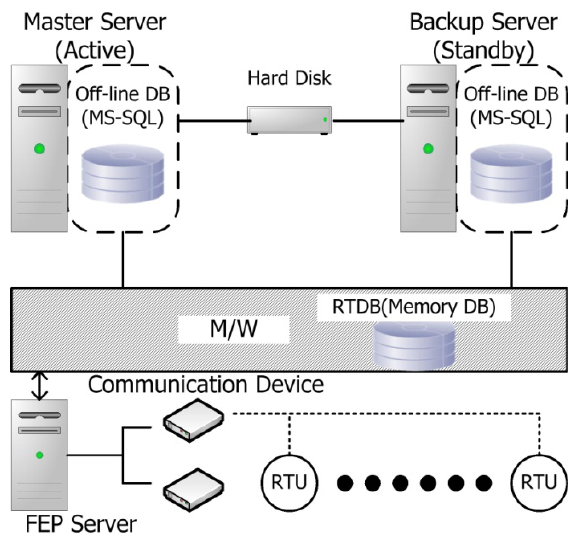
Figure 1. Database structure of conventional